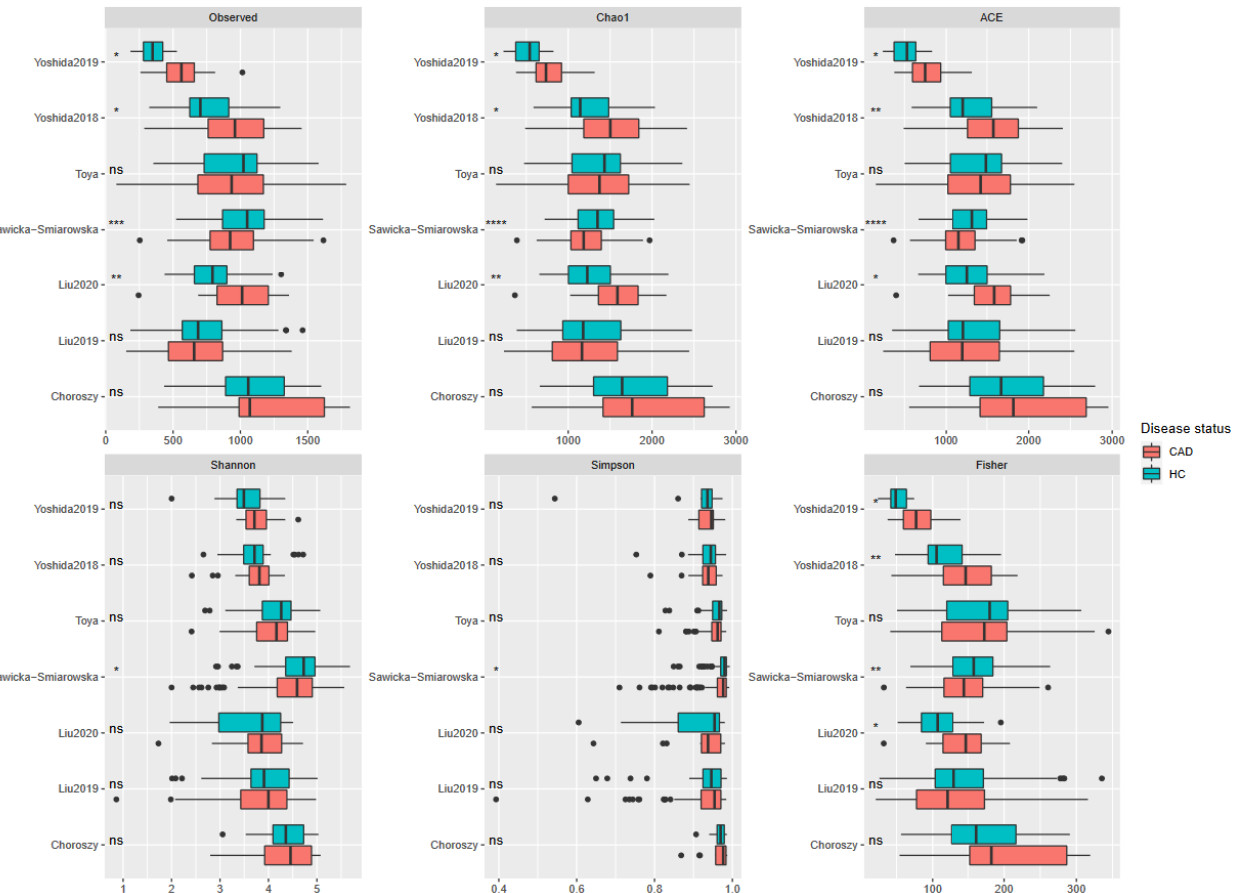
Figure 3. Alpha diversity results for individual studies. Asterixis describe statistically significant results: *- p ≤ 0.05, **- p ≤ 0.01, ***- p ≤ 0.001, ****- p ≤ 0.0001, ns-non-significant; dots denote outlier values.